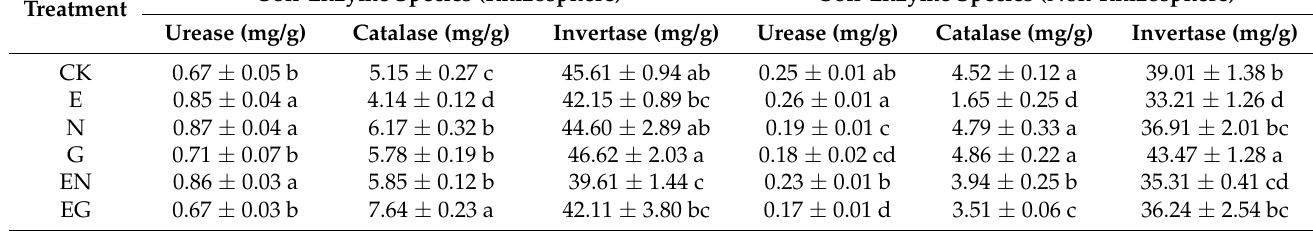
Table 3. Effects of different treatments on the enzyme activity of rhizosphere and non-rhizosphere soil. All data are shown as the means ± SDs ( n = 3). Different lowercase letters indicate that the mean values are significantly different among the treatments according to Duncan’s multiple range test ( p <